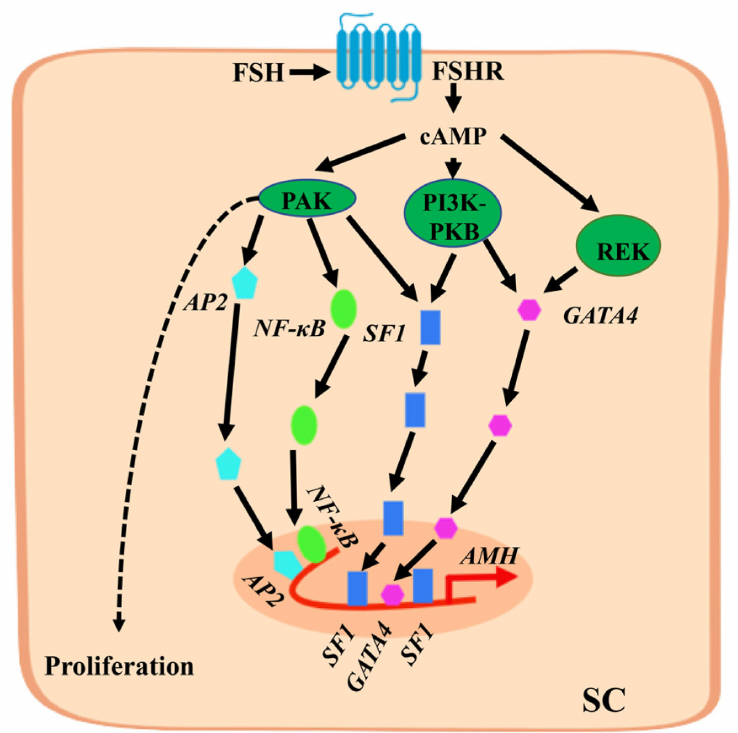
Figure 1. Mechanism by which follicle-stimulating hormone (FSH) stimulates anti-Müllerian hor- mone ( AMH ) gene expression in Sertoli cells (SCs). FSH binds to FSH receptor (FSHR) on SCs to induce an increase in cyclic adenosine monophosphate (cAMP) levels in the cytoplasm and activate protein kinase A (PKA), PI3K-PKB, REK, and other protein kinases. PKA is the main kinase involved in the up-regulation of AMH gene transcription, inducing the translocation of SOX9 , SF1 , and GATA4 transcription factors to enter the nucleus and bind to the proximal promoter region. It also increases the level of AP2 and NF- κ B transcription factors in the nucleus and binds to the distal promoter region sequence of the AMH gene. They jointly promote the expression of the AMH gene. The proliferation of SCs is also promoted by cAMP through